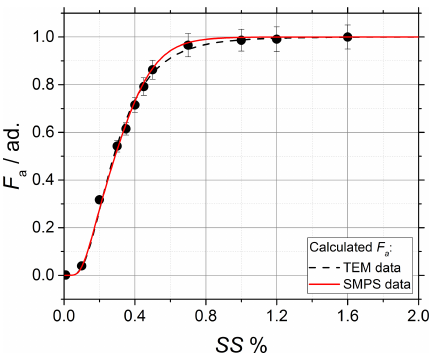
Figure 4. Dry ammonium sulfate particles: activation data obtained from CCNc experiments (black dots) and calculated F a = F a ( SS) using SMPS (solid red line) and TEM (dashed black lines) data as d ve